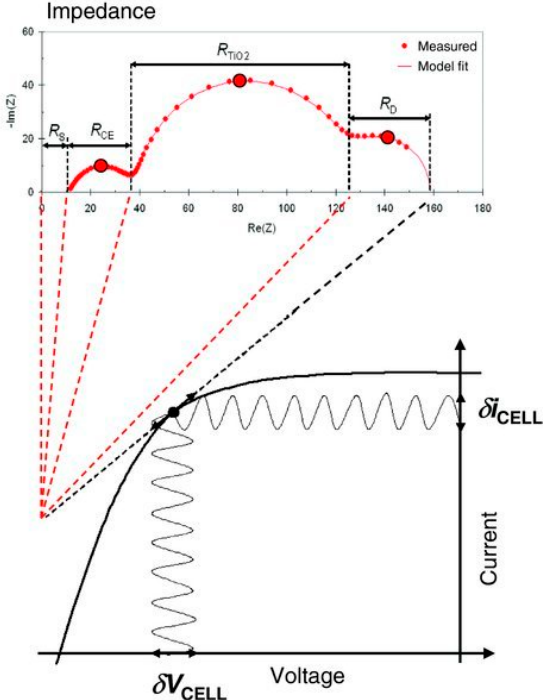
Figure 1. Schematic representation of the relationship between a current–voltage ( I – V ) plot and its differential resistances measured by electrochemical impedance spectroscopy (EIS). Individual differential resistance components of the I – V curve appear as separate impedance arcs due to their different characteristic frequencies. Reproduced with permission from Reference [8].